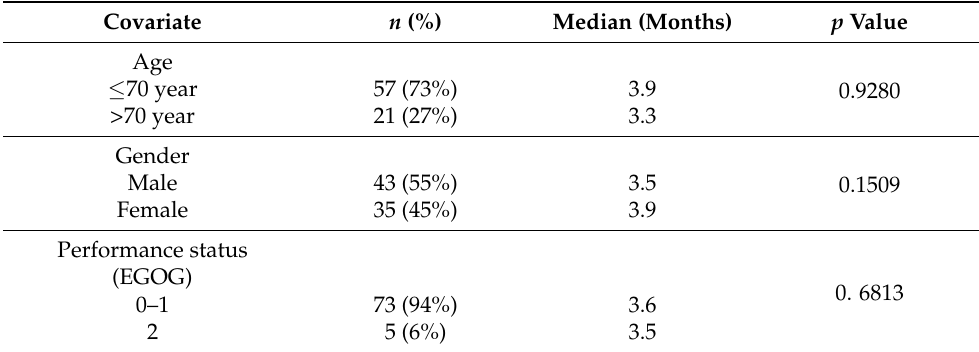
Figure 3. ( A , B ): Kaplan–Meier curves (KMC) showing progression-free survival under trifluridine/tipiracil. ( A ): KMC adjusted to baseline sarcopenia (yes or no); ( B ): KMC adjusted to carcinoembryonic antigen (normal or elevated); ( C ): KMC showing overall survival under trifluridine/tipiracil adjusted to SMI significant decrease on treatment (yes or no). Table 3. Univariate analysis of progression free survival (log-rank